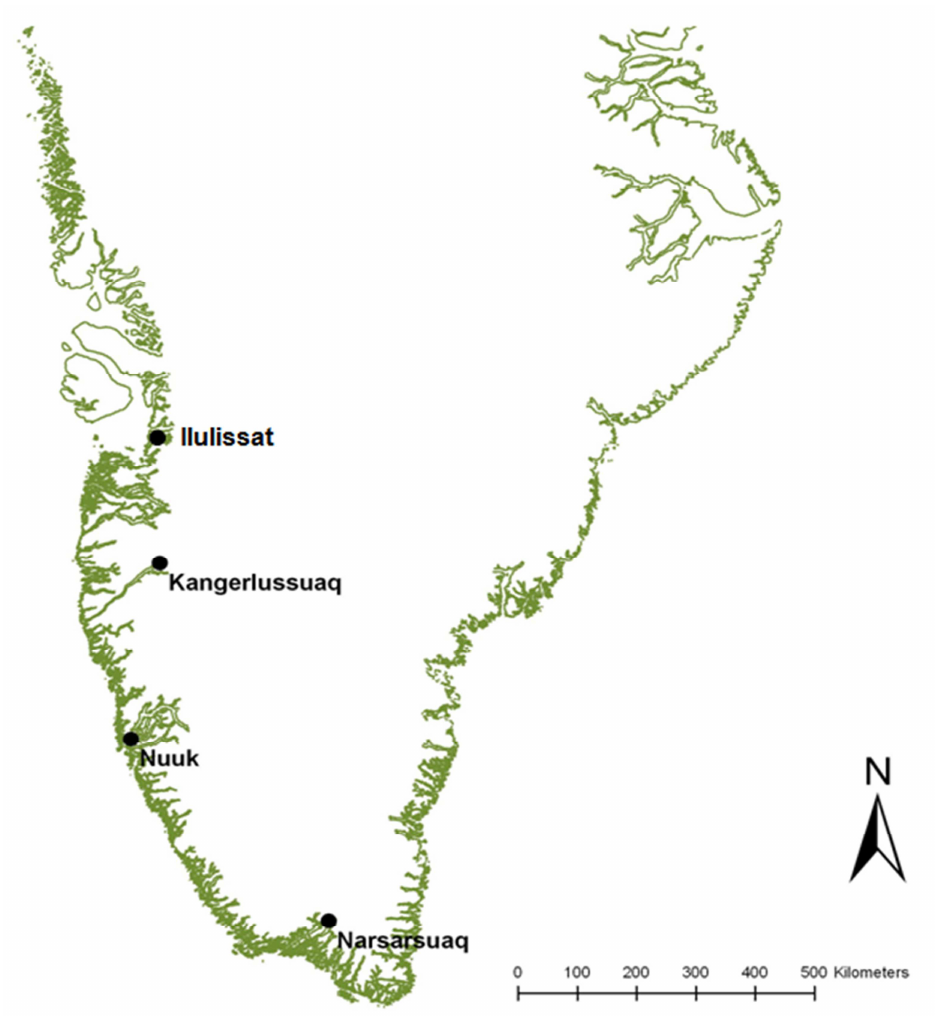
Figure 2. Location of the four main airports in Greenland (Salling and Banister,